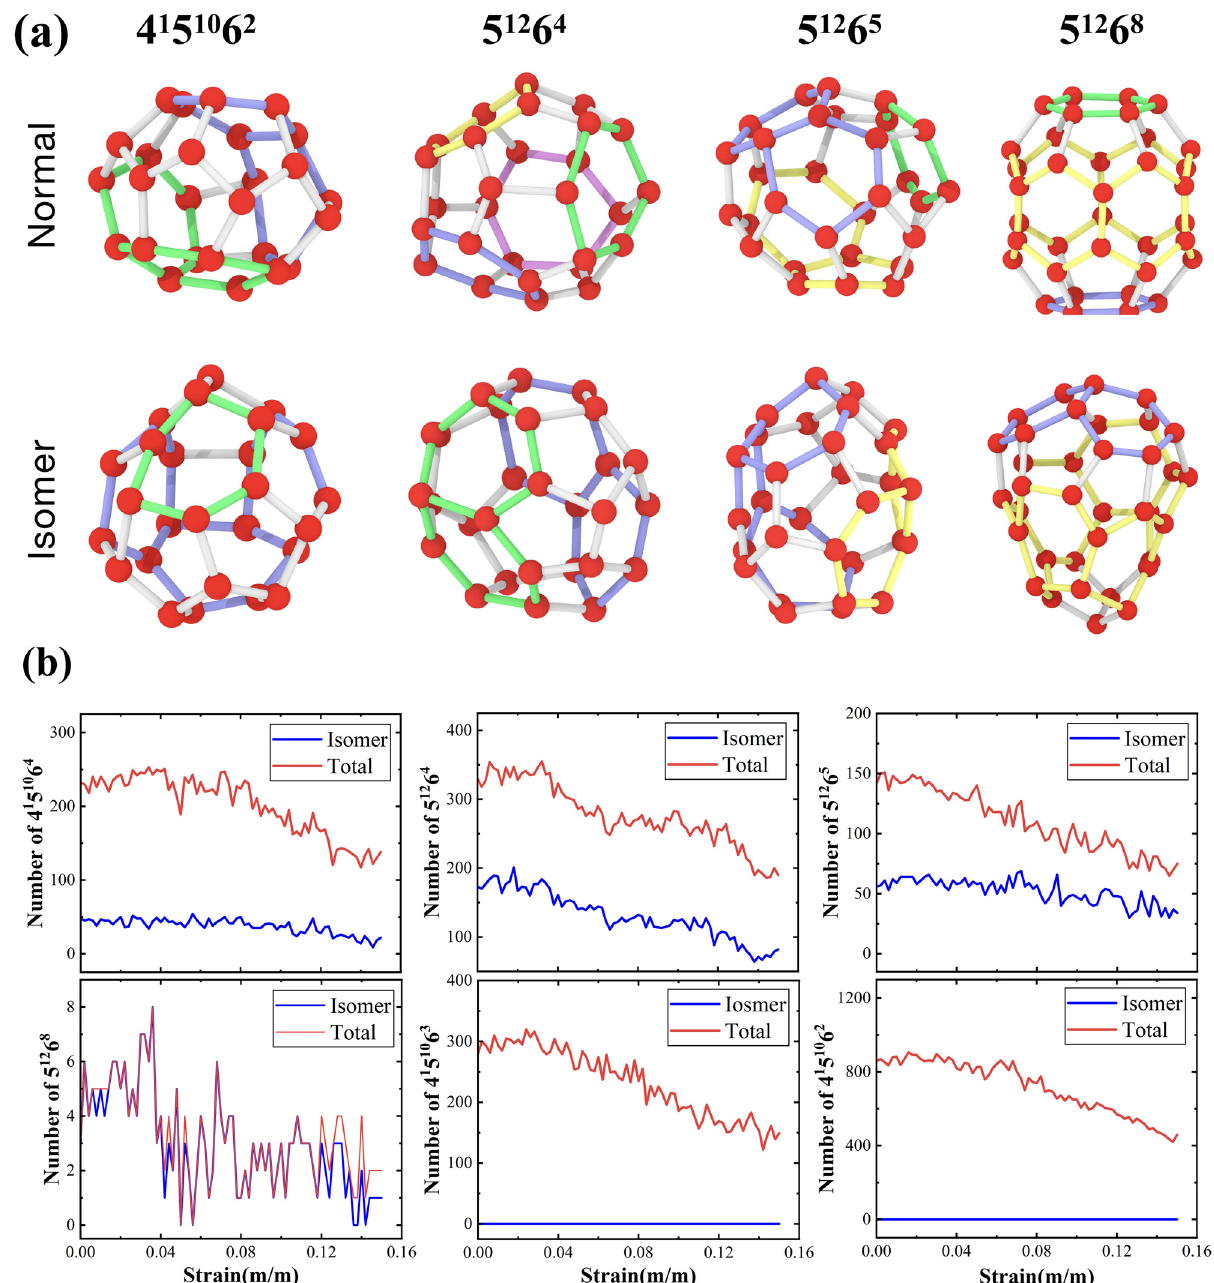
Figure 12: HTR identi fi ed isomer cages in the polycrystalline stretching process of a system of 314,664 water molecules. ( a ) The colored rings are all six - membered rings, and two six - membered rings that share a hydrogen bond are represented by the same color. ( b ) Number of isomers and total cages along with the stretching